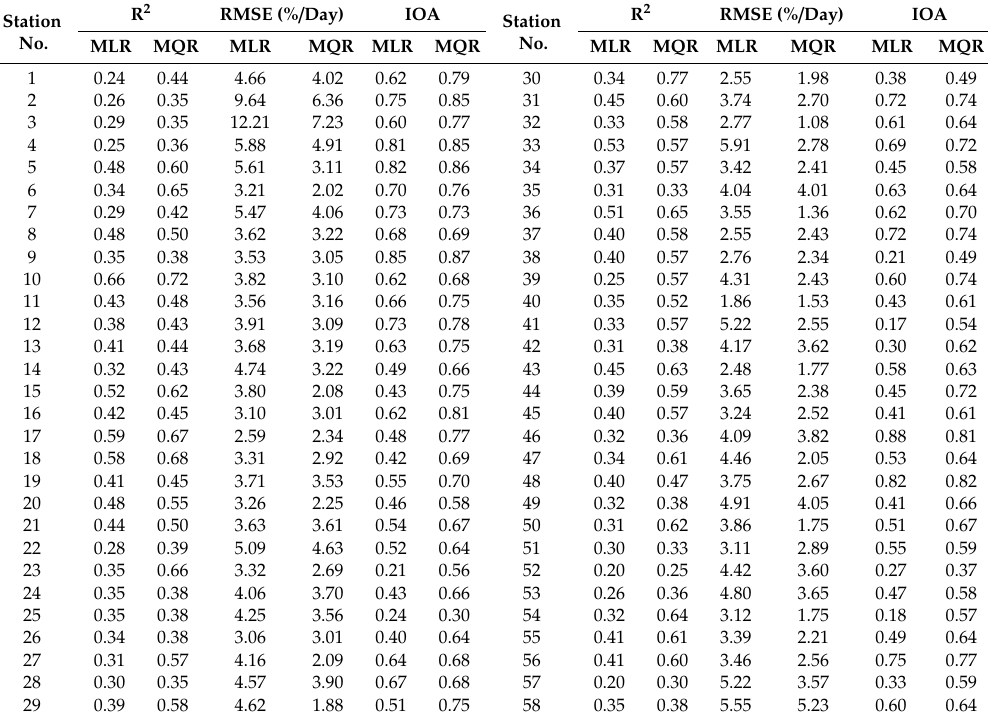
Table 4. Comparison of the statistical analysis results between the multiple linear regression (MLR) and MQR models at 58 SM